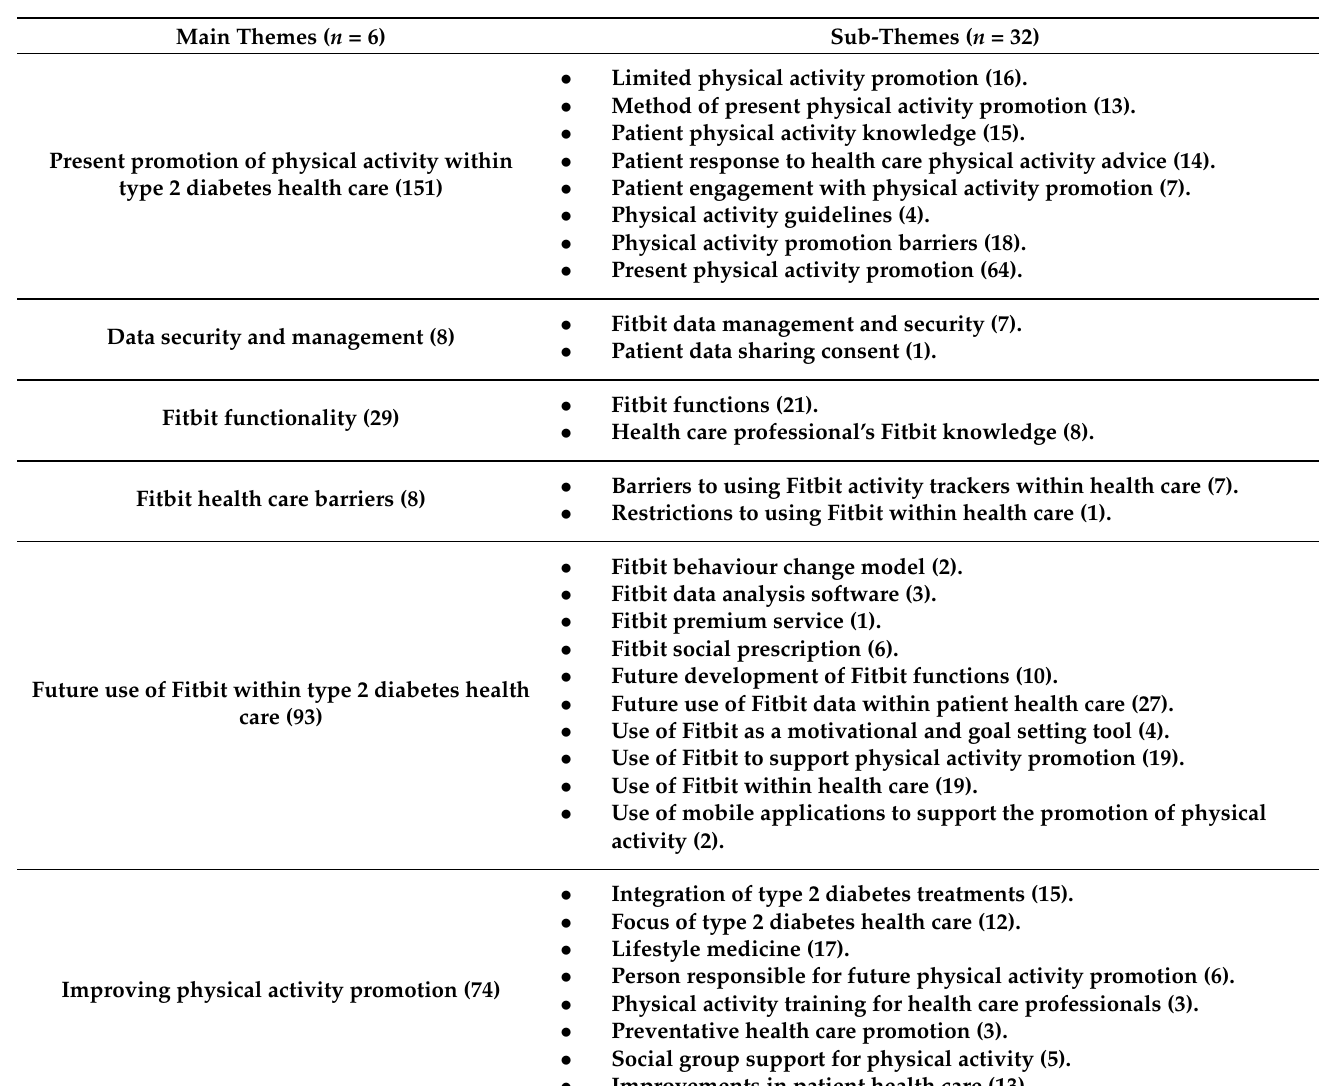
Table 4. Identified main themes and associated sub-themes with the number of in-text references displayed in brackets. Main Themes ( n =